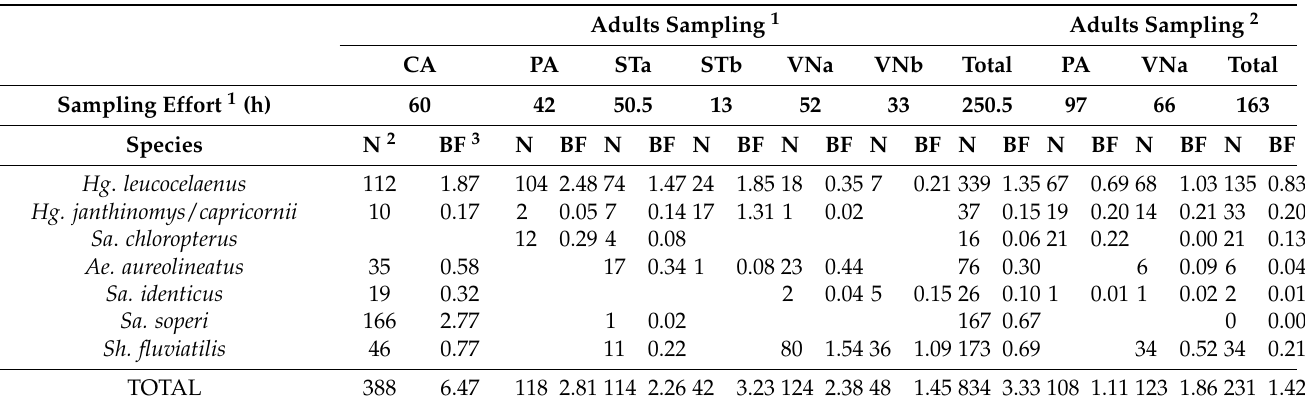
Table 2. Biting frequency of YFV vector species in Cariacica (CA), Pancas (PA), Venda Nova do Imigrante (VNa and VNb), and Santa Teresa (STa and STb), Esp í rito Santo, from February to June